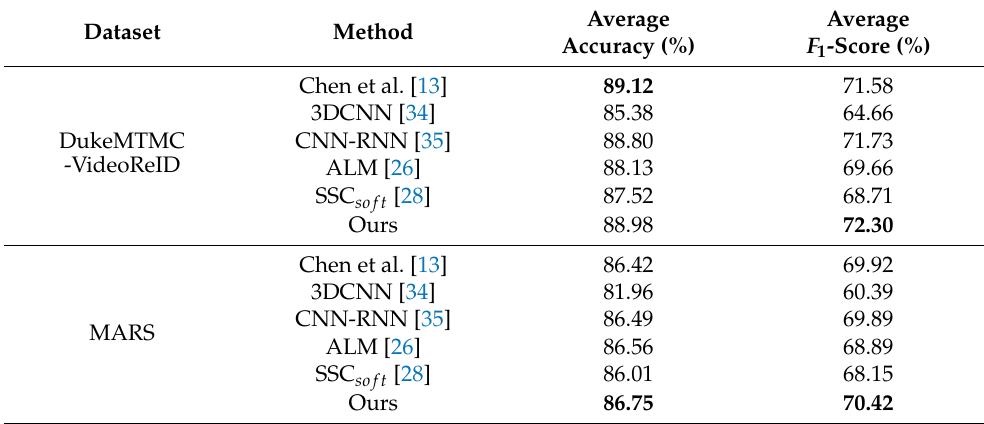
Table 3. Comparisons of the results for the total samples of the DukeMTMC-VideoReID and MARS datasets. The bold indicates the best